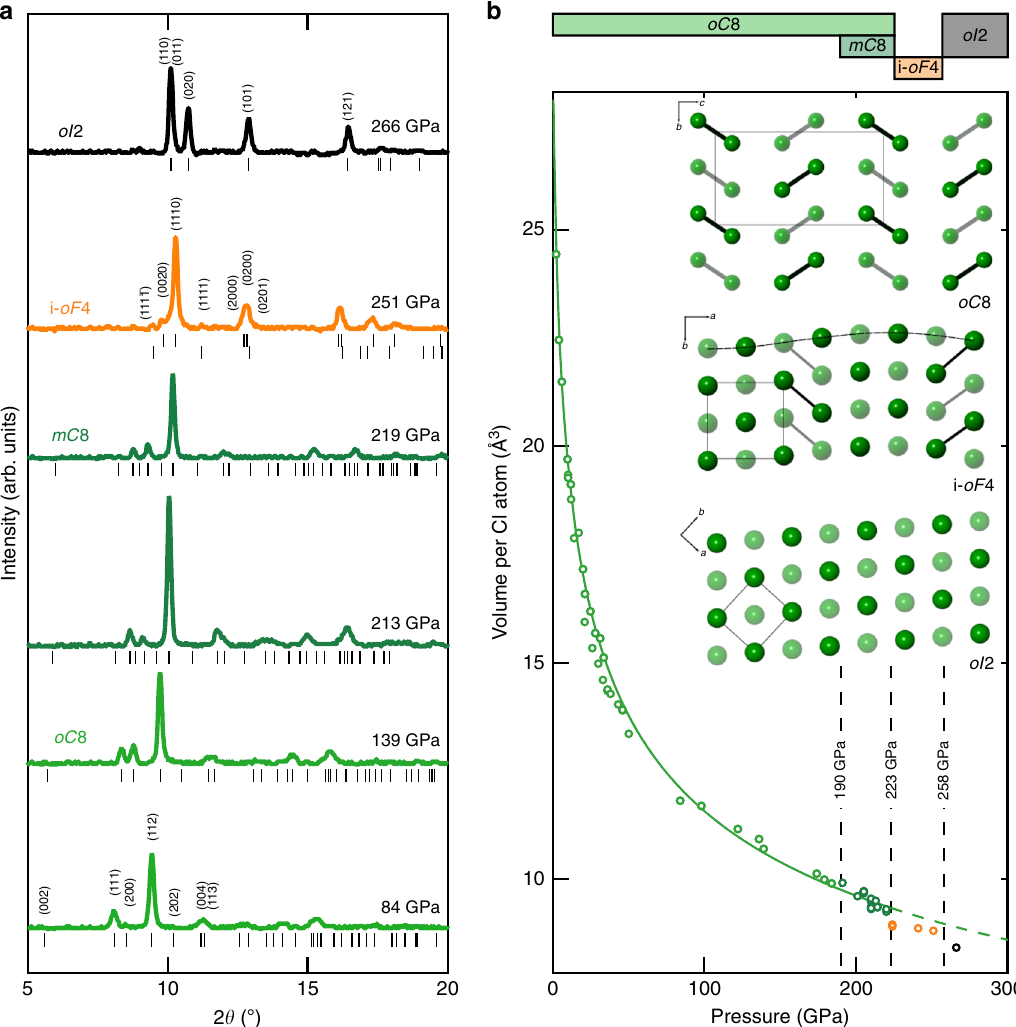
Fig. 3 X-ray diffraction measurements. a High-pressure X-ray diffraction patterns ( λ = 0.3344 Å) of chlorine with increasing pressure. At 251 GPa, chlorine adopts an incommensurate structure based on a face-centred orthorhombic parent phase whose re fl ections are marked with the upper set of tick marks. Satellite re fl ections are shown with the lower set of tick marks. At 266GPa chlorine has transformed to an atomic phase crystallising in a body-centred orthorhombic unit cell; b volume per Cl atom as a function of pressure. A third Birch-Murnaghan equation of state 53 was used to describe the pressure evolution ( V 0 = 29.1222 Å, K 0 = 8.3(11) GPa, K ’ = 5.6(4)), denoted by the solid green curve, to the molecular oC 8 and mC 8 phases. The 1-D phase diagram atop of the fi gure provides the phase behaviour of chlorine as observed with X-ray diffraction. Inset — crystal structures in the b – c plane of oC 8, i-oF 4 and oI 2 of chlorine, differences in the opacity represent atoms belonging to different layers in the structures. Top panel — oC 8 ( Cmce ), where distinct differences in intermolecular and intramolecular distances are observed. Middle Panel — i-oF 4, a modulated structure as a precursor to complete molecular dissociation. Bottom panel — oI 2 ( Immm ), the simple close-packed structure of atomic